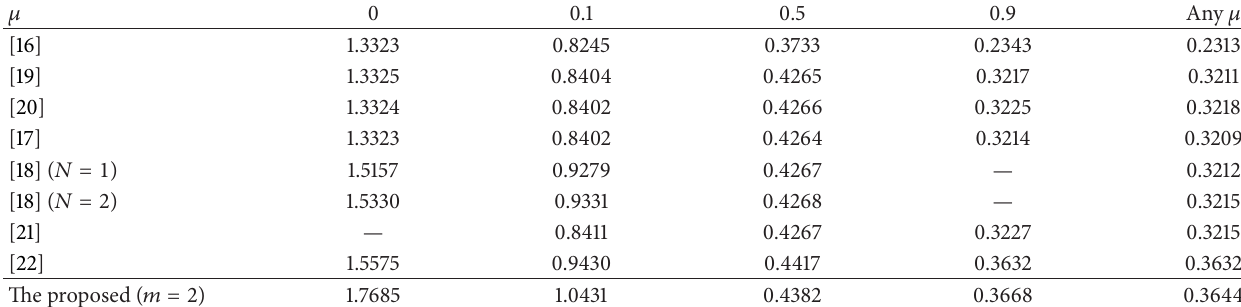
Table 1: Allowable upper bounds of ̄𝜏 for different 𝜇